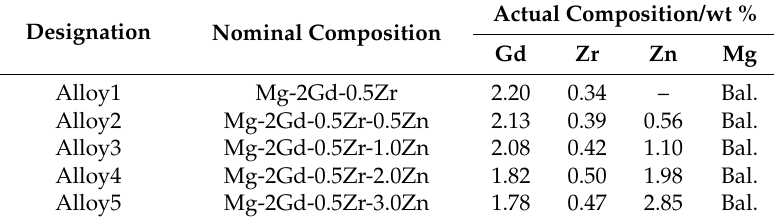
Table 1. Chemical composition of as-cast alloys.